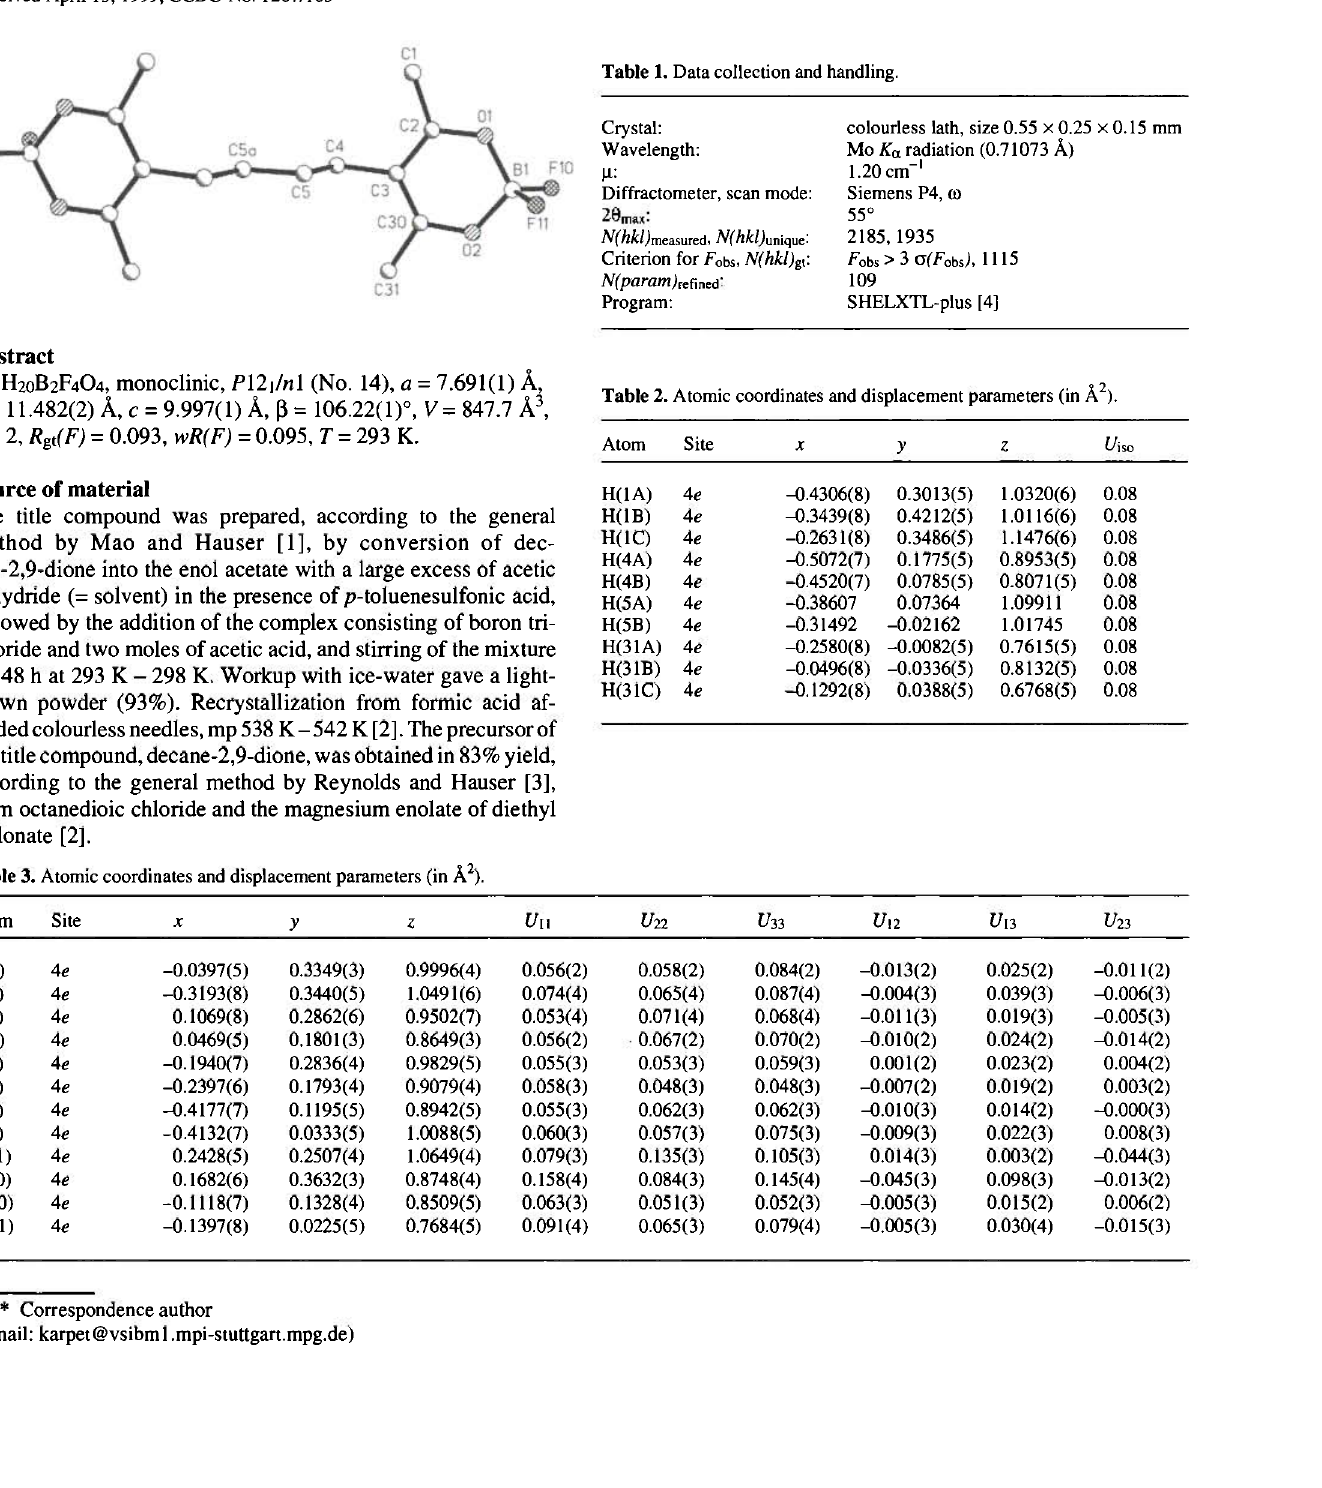
Table 1. Data collection and handling.